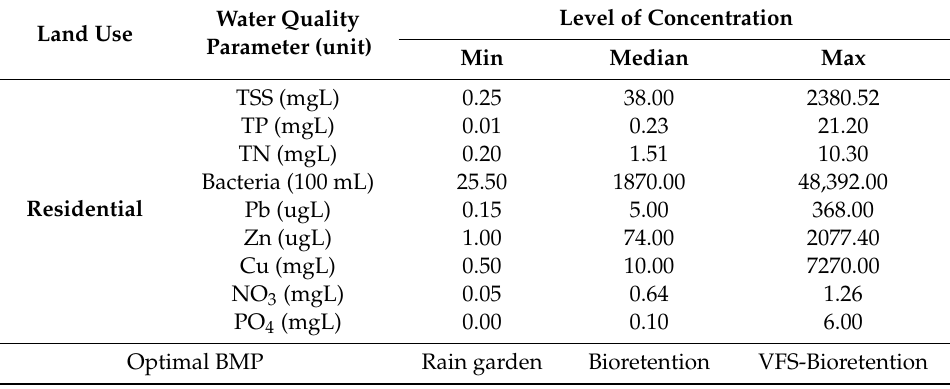
Table 6. BMP selection by land use (industrial) and pollutant concentration. Land